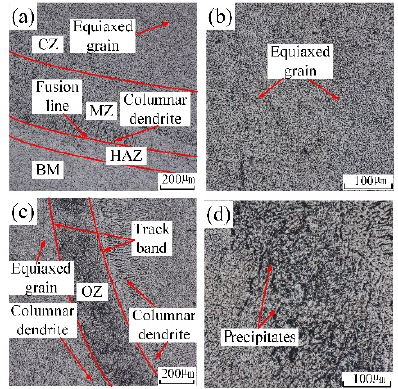
Figure 8. The grain morphology near the in-air and underwater fusion line: ( a ) the in-air grain mor- phology; ( b ) the underwater grain morphology. Figure 9. The distribution of grain sizes in the in-air and underwater OZs: ( a ) the in-air OZ; ( b ) the underwater OZ.